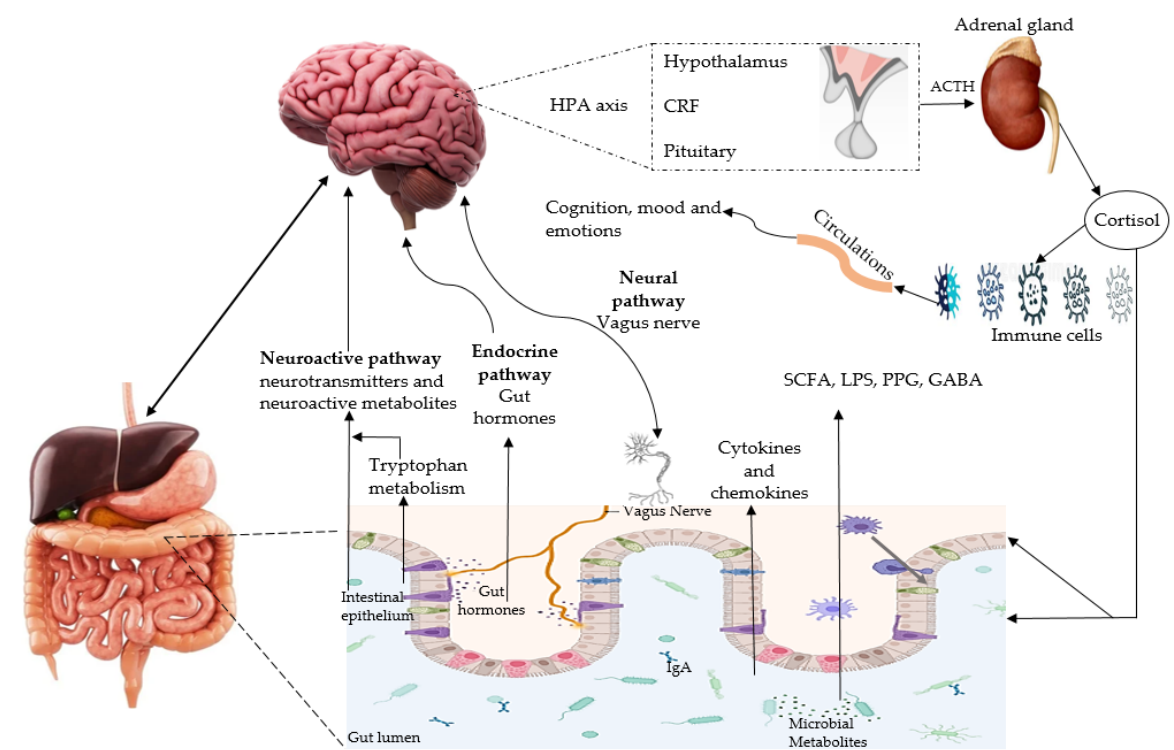
Figure 2. The microbiota-gut-brain axis is the bidirectional pathway between intestinal microbiota, the gut, and the central nervous system. It can be modulated by gut microbiota through endocrine (cortisol), neural (enteric and vagus nervous system), and immune (cytokines) systems. Microbial metabolites (LPS, GABA, SCFA, and PPG) and other neurotransmitters also participate in GM modulation. Gut dysbiosis can alter the tryptophan levels, hormones, SCFA, immune system, and gut permeability. Furthermore, release of cytokines and chemokines contribute to neuroinflammation and activate HPA axis (affecting gut permeability, barrier function, and immune cells through the secretion of cortisol). HPA axis: hypothalamic-pituitary-adrenal axis, ACTH: adrenocorticotropic hormone, CRF: corticotropin-releasing factor, LPS: lipopolysaccharides, GABA: y-aminobutyric acid, PPG: peptidoglycans, SCFA: short-chain fatty acids.